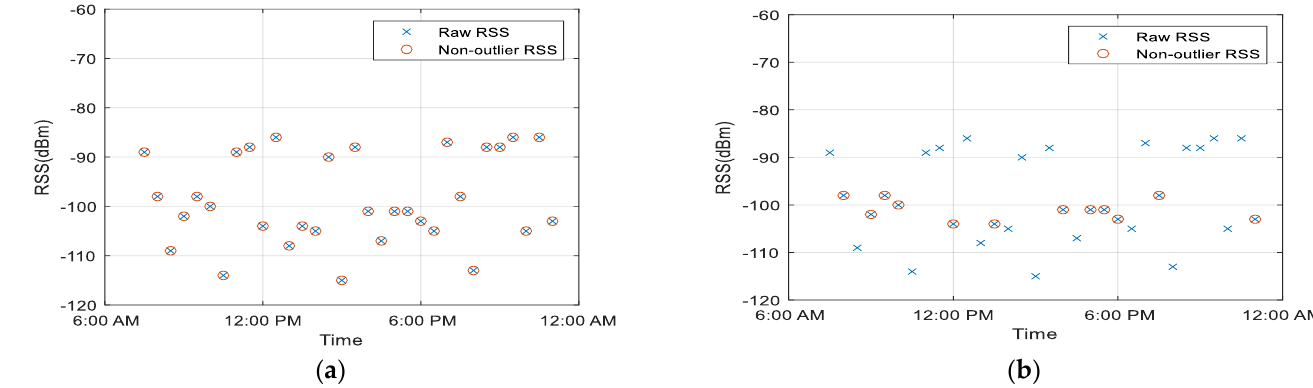
Figure 10. RSS outlier detection comparison for RSS Dataset 8. ( a ) 𝑆 𝑛 scale estimator, and ( b ) MAD scale estimator.